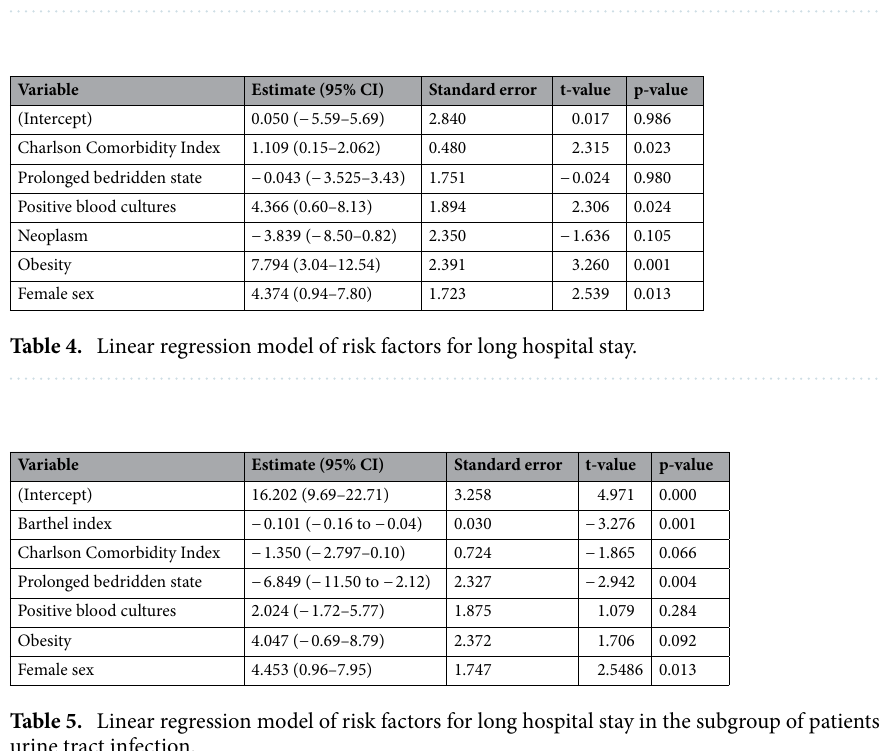
Table 3. Detail on microbiological test and therapeutic parameters.